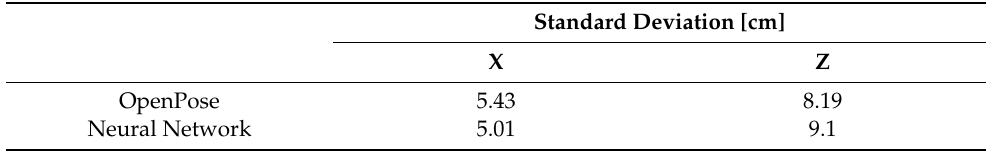
Figure 12. Dispersion of points obtained thanks to OpenPose software compared with the neural network results (for acquisition 2). Table 2. Standard deviation value comparison highlighting consistency between the points acquired and processed by means of OpenPose and estimated by means of neural